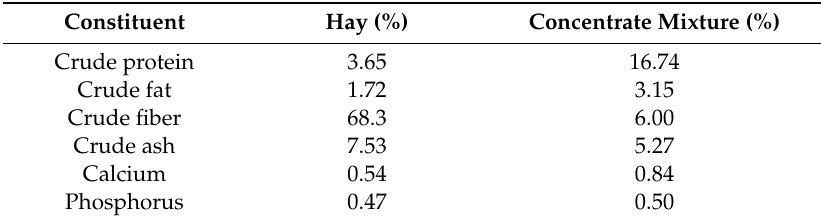
Table 1. Nutritional composition of concentrated feed mixture and hay